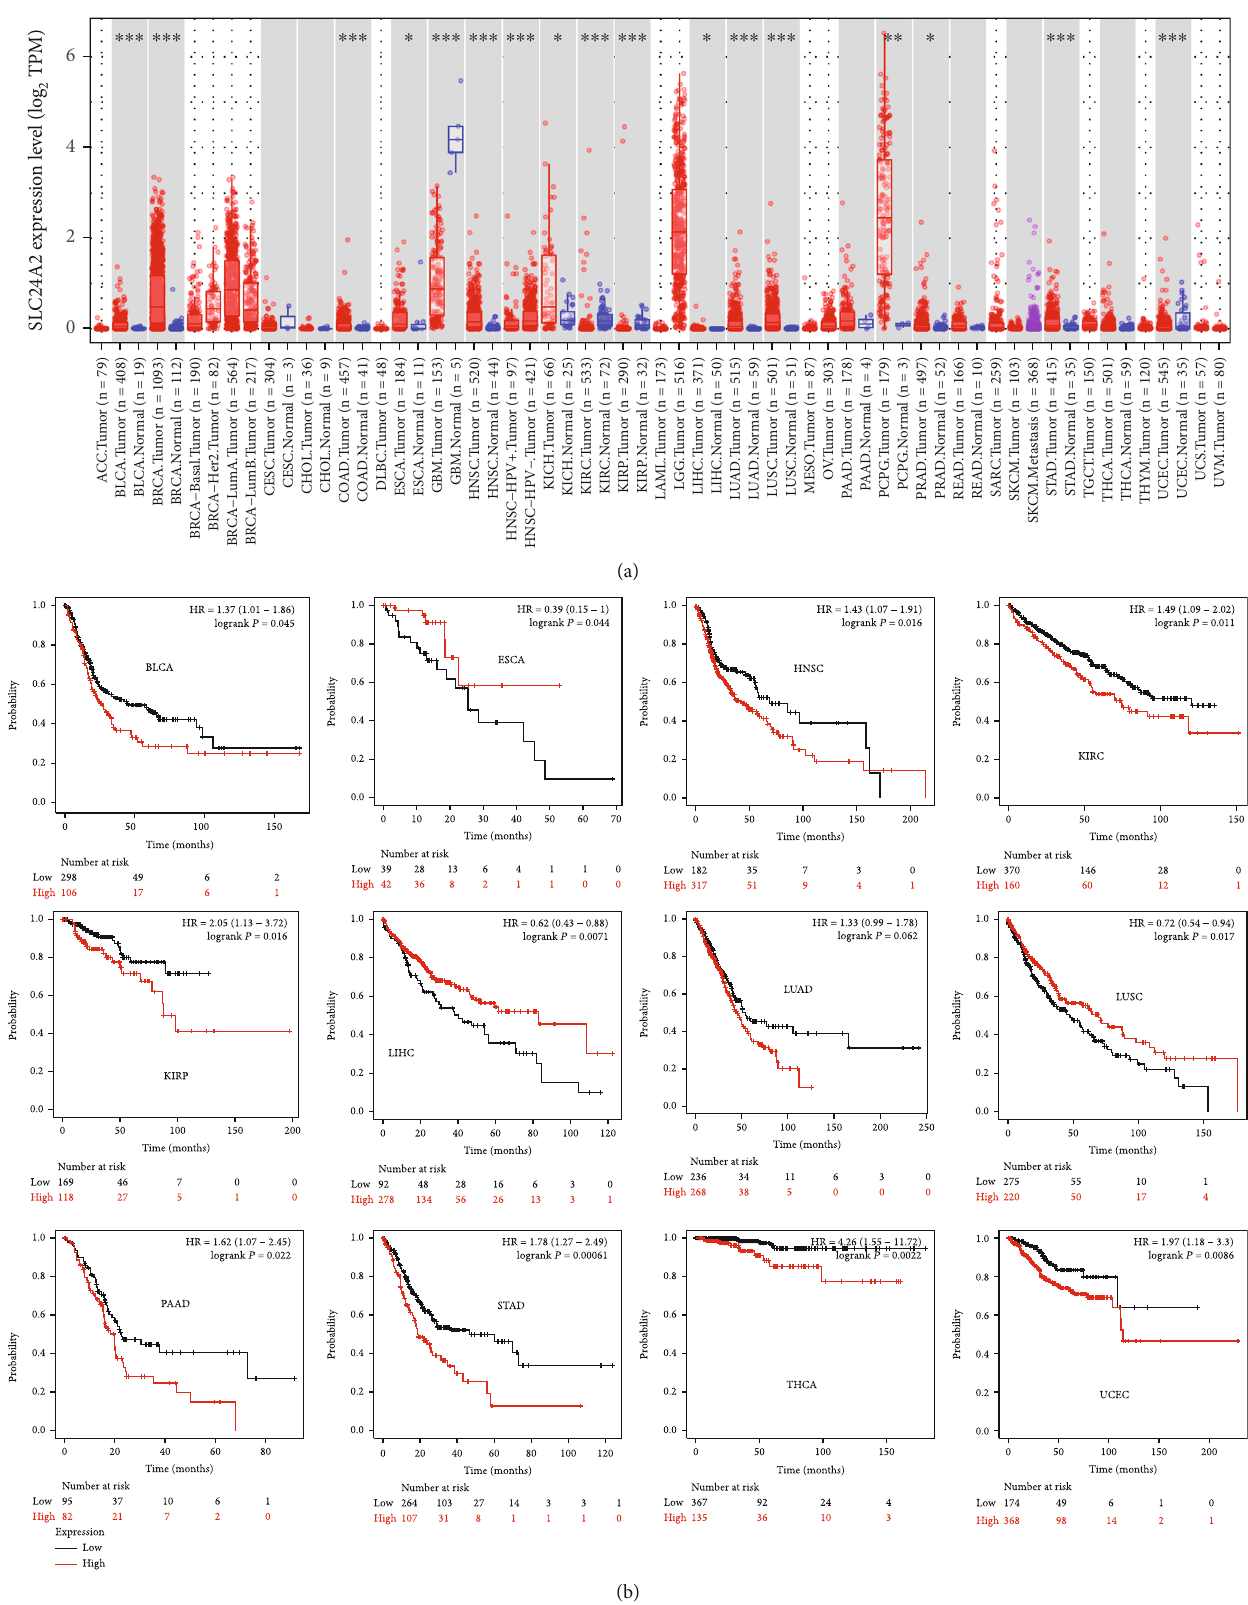
Figure 6: Expression and prognostic analysis of SLC24A2 in pan cancer. (a) The expression of SLC24A2 in pan cancer. (b) Prognostic analysis of SLC24A2 in pan